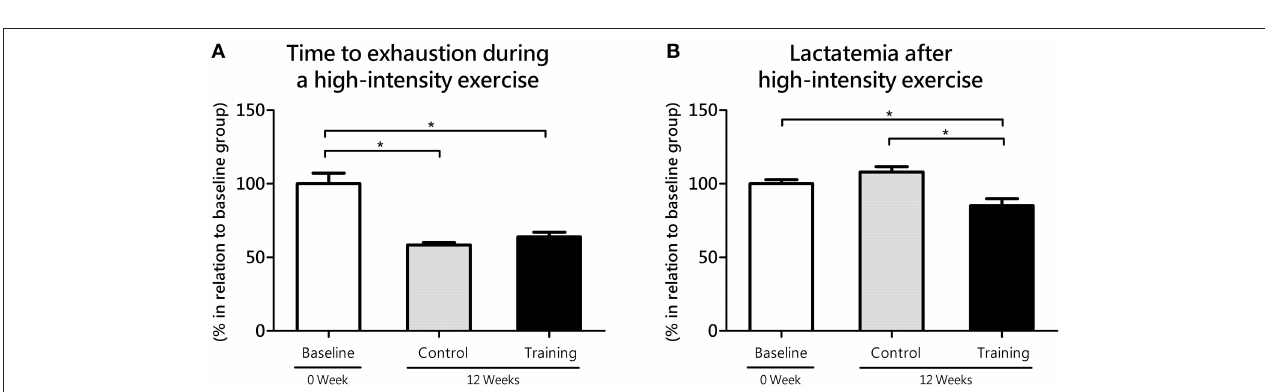
FIGURE 2 | The lactate minimum intensity (A) relative to the animal’s body mass (aerobic parameter) and blood lactate levels (lactatemia) at this intensity (B) for the control and training exercise groups. The data (mean ± SEM) are relative (%) to baseline group, which has been set at 100%. Newman-Keuls post-hoc test was used to locate group’s difference. N = 7 –10 animals per group. Sig. diff. * P < 0.05 .